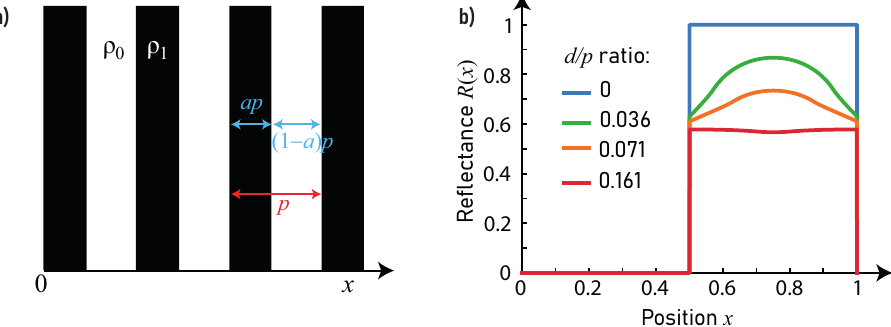
Figure 3. ( a ) Line halftone pattern and parameters associated; ( b ) local reflectance profile as a function of position x for different d/p